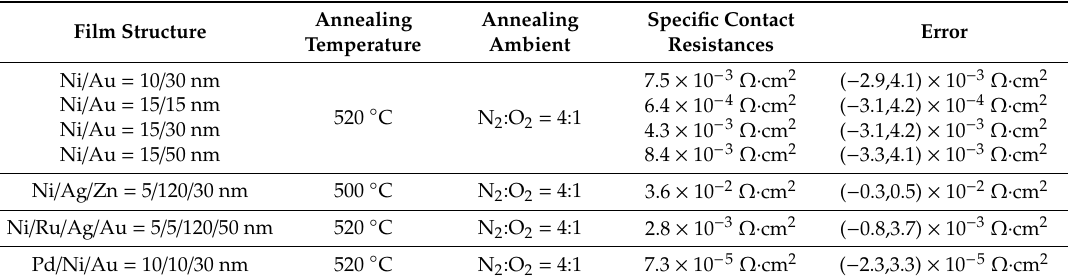
Figure 4. c-TLM data of Pd (10 nm) / Ni(10 nm) / Au(30 nm) contacts on GaN laser diode sample in a mixture of nitrogen and oxygen ambient after annealing at 520 °C for 5 min. Table 2. The specific contact resistances detail of a variety of metal schemes.